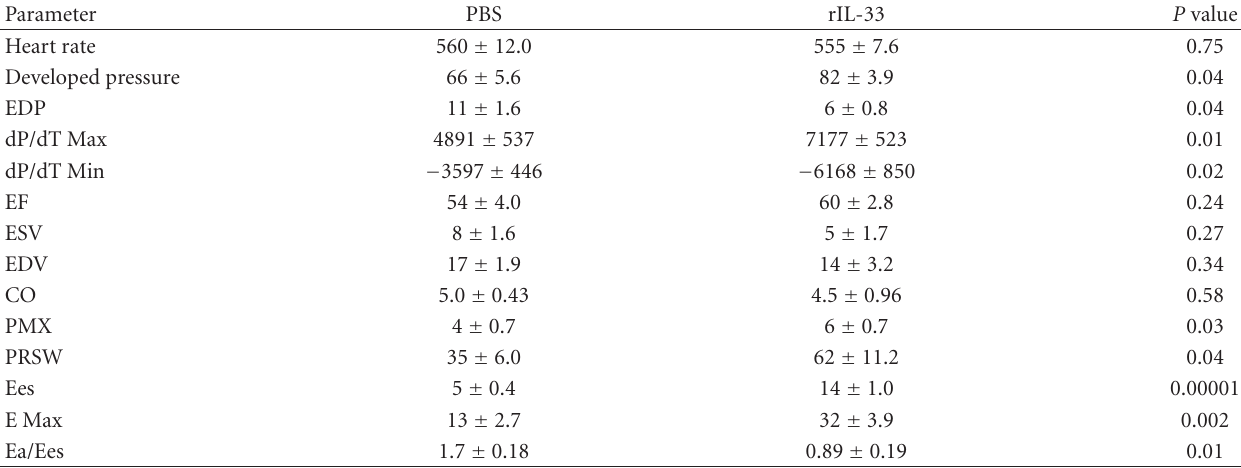
Table 2: In vivo hemodynamics of recombinant (r)IL-33-treated TLR3-deficient mice during acute CVB3 myocarditis (day 10 pi) based on pressure-volume